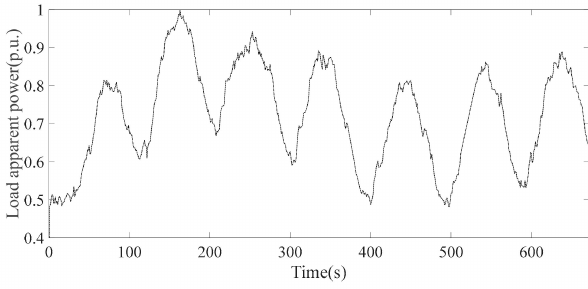
Figure 6. Output curve of each load of the internal system.